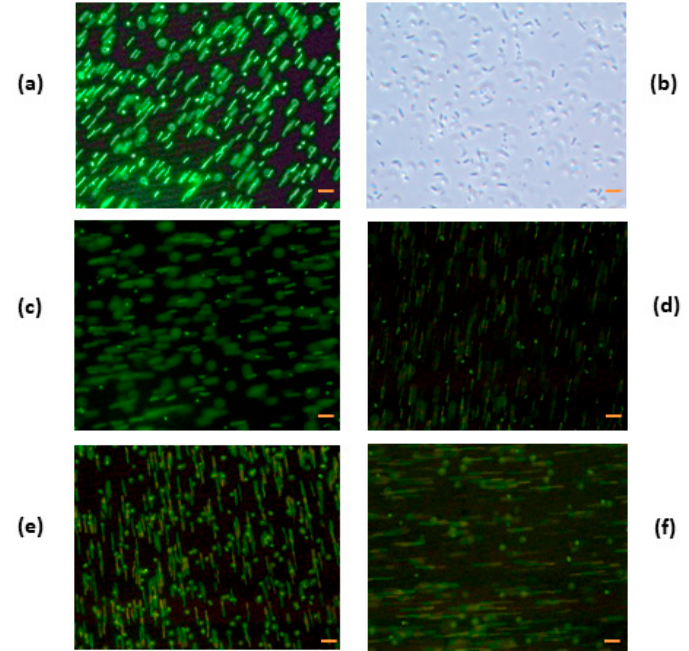
Figure 6. Fluorescence micrographs of Escherichia coli incubated with heat-treated hen egg white lysozyme (HEWL) at pH 7.0. ( a ) E. coli control without HEWL, ( b ) E. coli control without HEWL without fluorescence, ( c ) E. coli incubated with HEWL/80 °C, ( d ) E. coli incubated with HEWL/90 °C, ( e ) E. coli incubated with HEWL/95 °C, and ( f ) E. coli incubated with HEWL/120 °C. Bacteria control and bacteria with sample were incubated for 15 h at a concentration of 0.5 mg/mL. Bar = 2 μ m.